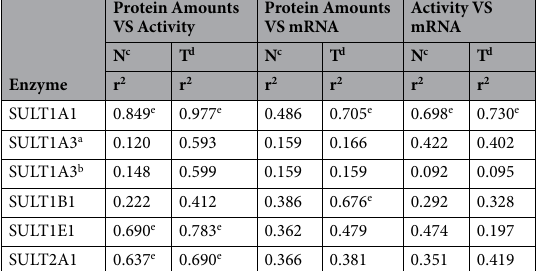
Our results also showed that the LC-MS/MS method for detecting SULT enzymes with respect to specificity, accuracy and speed is superior to the current methods for detecting the expression levels of SULT enzymes based on Western blot or RT-PCR. For SULT enzymes, the mRNA expression levels cannot reflect protein expression, and Western blot analysis involves long and complex experimental procedures that may be compromised because of the lack of highly specific antibodies 33 . By contrast, the precision and accuracy of the new method meet strict quantification standards, for the determination of CYP and UGT protein amounts in human liver microsomes in a previous study 22 and in other research laboratories 34, 35 . The robust method is reproducible and reliable. Large amounts of data demonstrated that protein (SULT) amounts as measured using LC-MS/MS were more representative of the probe substrate activities than the expression levels derived from q-PCR or some Western blot. The advantages of the LC-MS/MS method include its specificity, whereas antibodies are only specific 40%